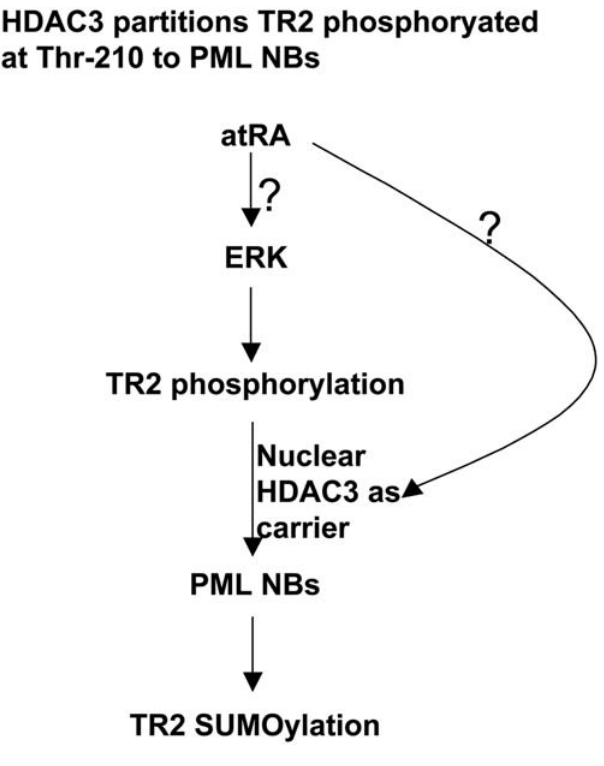
Figure 4. Schematic of events leading to TR2 association with PML NBs for SUMOylation. atRA activates ERK2 nongenomically, which in turns phosphorylates TR2 at Thr-210. This facilitates its recruitment to HDAC3 that shuttles TR2 to PML NBs for subsequent SUMOylation. Two major outstanding questions in this signaling pathway are pointed out with question